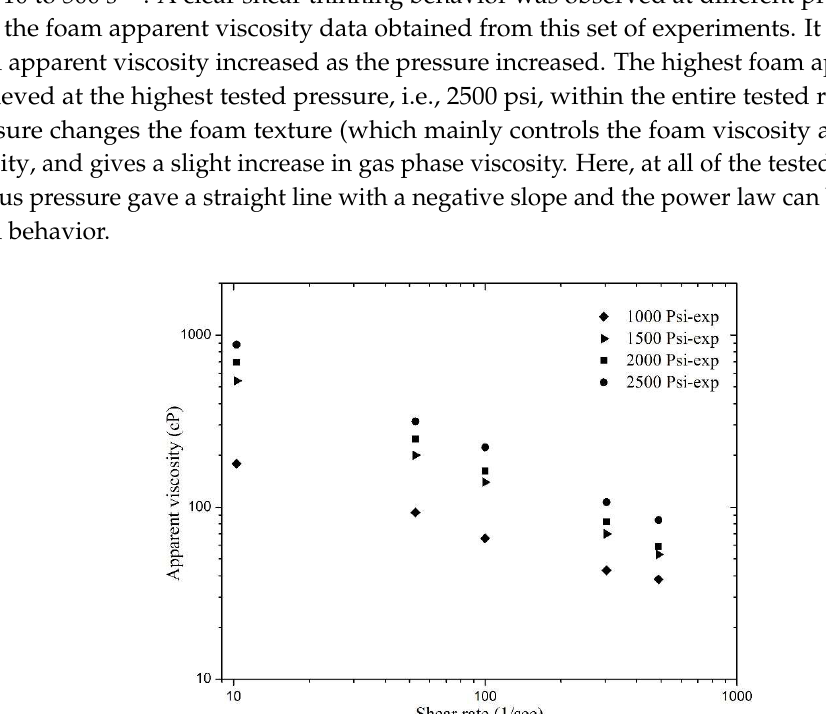
Figure 6. Apparent viscosity of sCO 2 foam with the effect of pressure and shear rate.